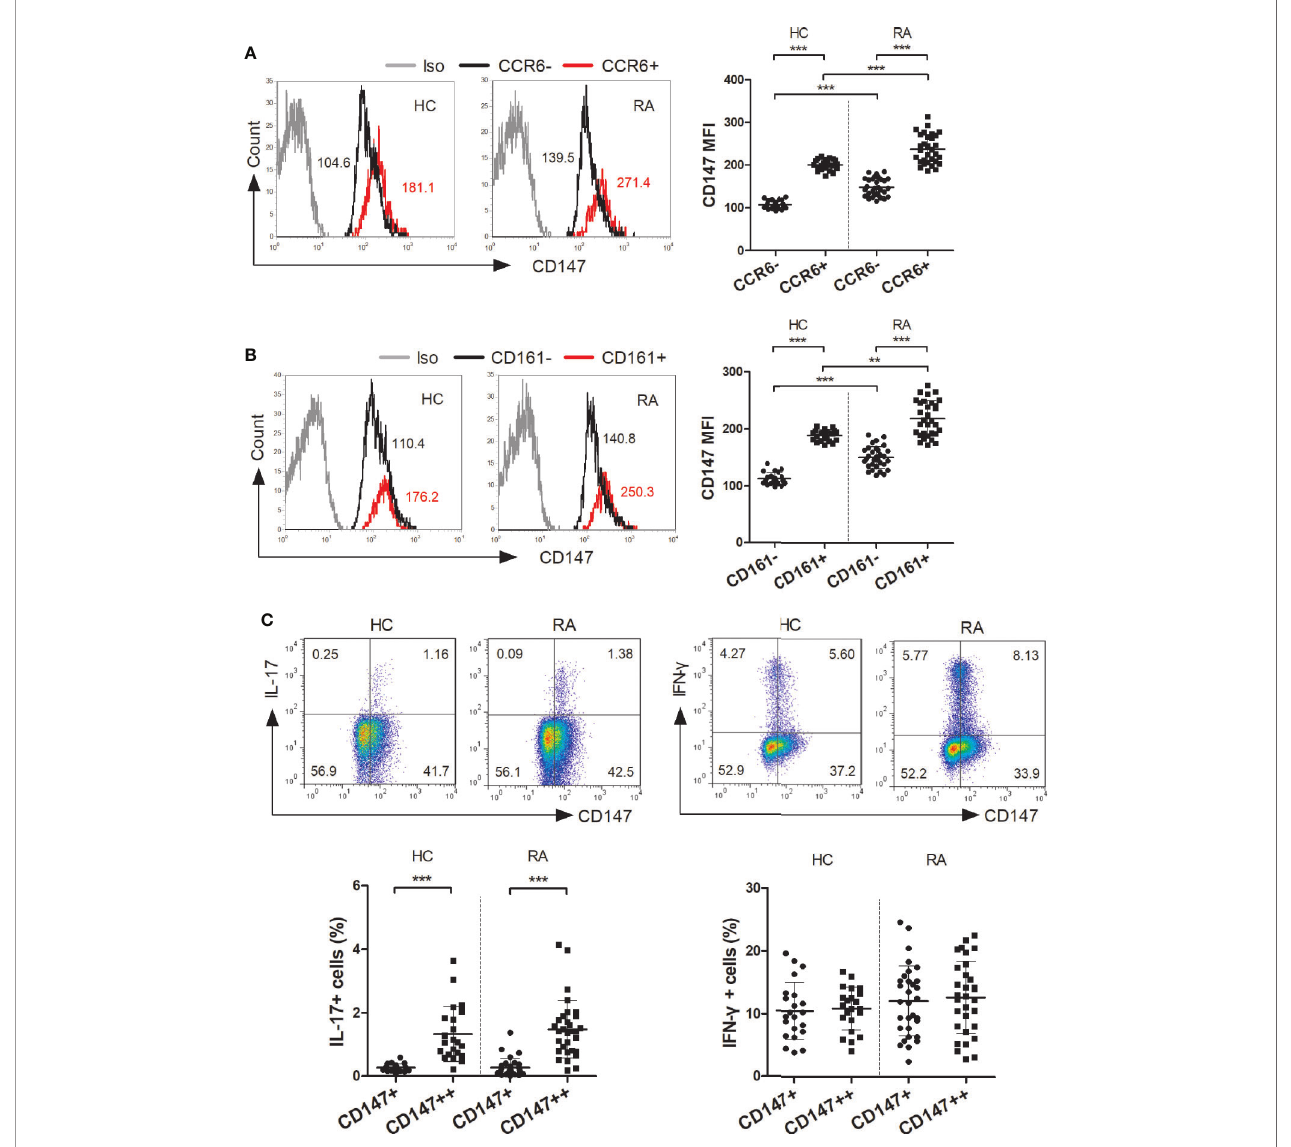
FIGURE 1 | CD147 expression was associated with IL-17 production. (A, B) Flow cytometry was used to assess CD147 expression on circulating CD4 + T cell subsets, including CCR6 − /+ cells (A) and CD161 − /+ cells (B) , from healthy control (HC; n = 22) and rheumatoid arthritis (RA) patients (n = 31). (C) Flow cytometric dot-plots and cumulative data of intracellular IL-17 and IFN- g production in CD4 + T cells and strati fi ed by their CD147 expression obtained from HC (n = 22) and RA patients (n = 31). Iso, isotype control mAb; ** P < 0.01; *** P <